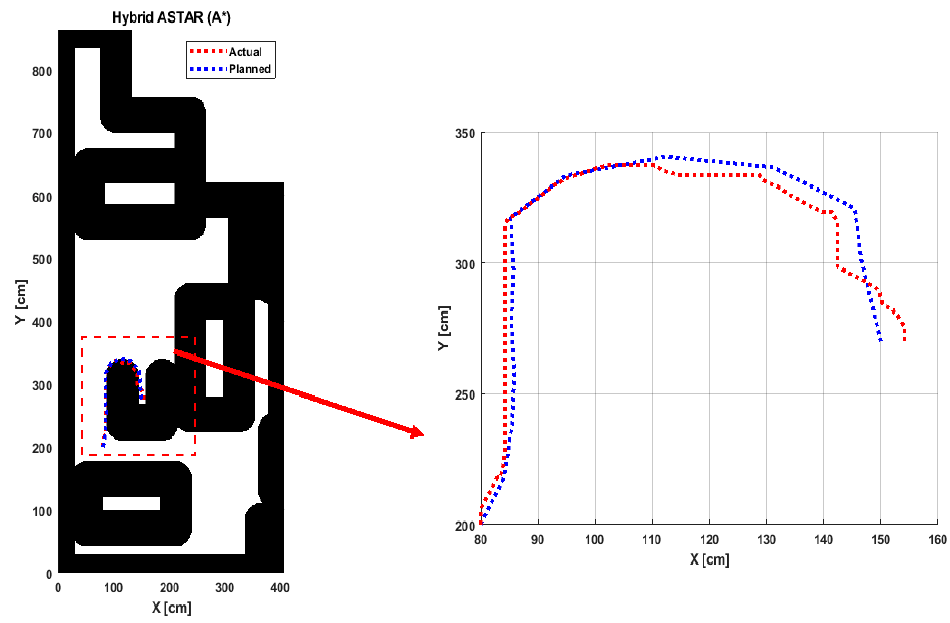
Figure 12. The experimental path that is generated by using Hybrid A* in Map2. The blue line is the planned path, while the red line is the actual path. The generated path has a travel distance = 2.47 × 10 2 cm, an average velocity of 0.1106 m/s, a travel time of 23.62 s and a maximum acceleration of 0.192 m/s 2 . The real final point is varied from the planned as the absolute error point on the X- and Y-axes and is 4.2 cm and 0.9 cm, respectively.